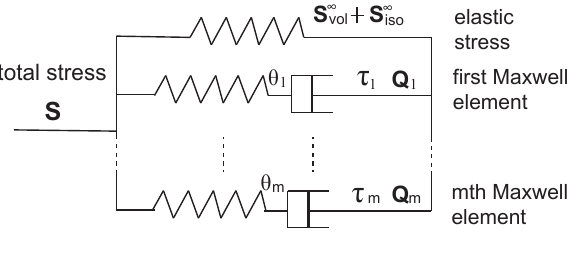
Figure 15. Schematic model of a viscoelastic material. The total stress S decomposes according to Equation (45). The spring in the first row represents the elastic stress, while the Maxwell elements contribute the non-equilibrium stresses Q n , n = 1,..., m . The mechanical properties of the springs and dashpots of Maxwell elements are defined by the free-energy parameters θ and the relaxation times τ ,